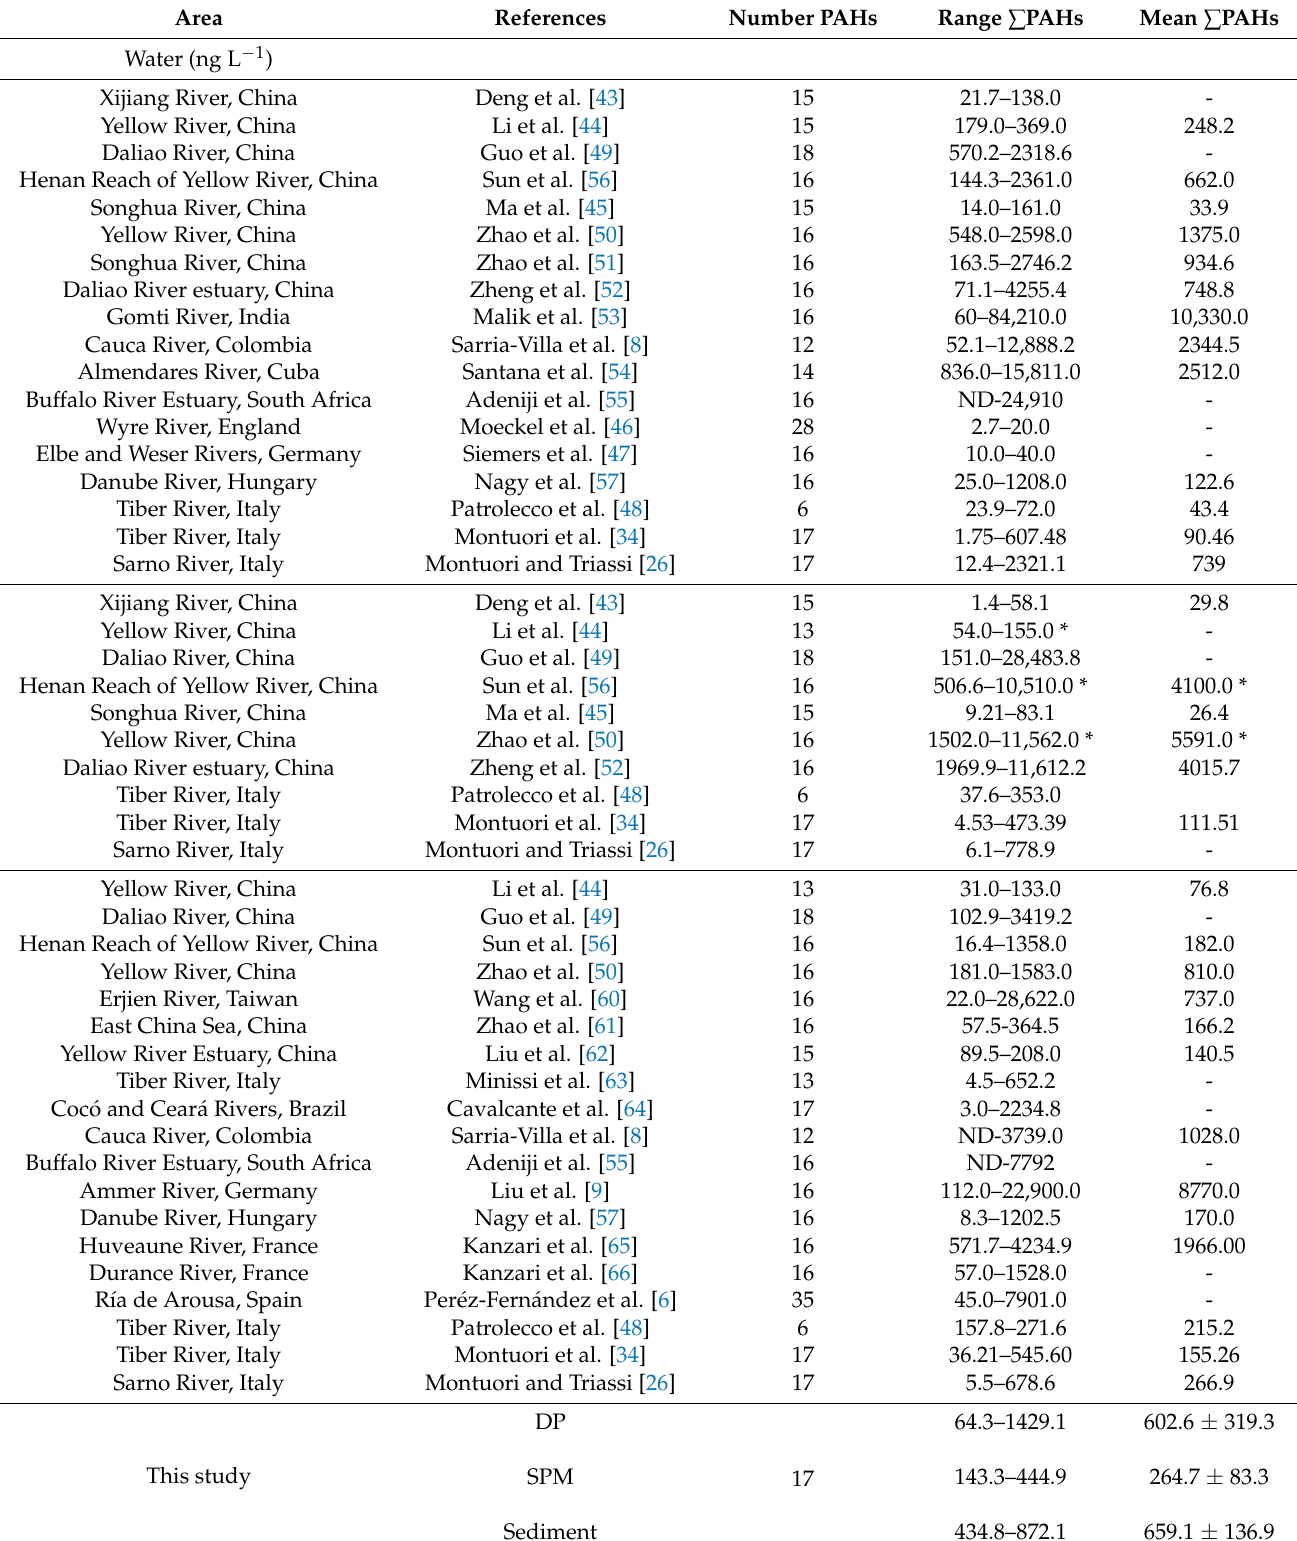
Table 2. Concentration ranges and mean value of PAHs in the water dissolved phase (DP), suspended particulate matter (SPM), and sediments from recent studies of different rivers and estuaries in the